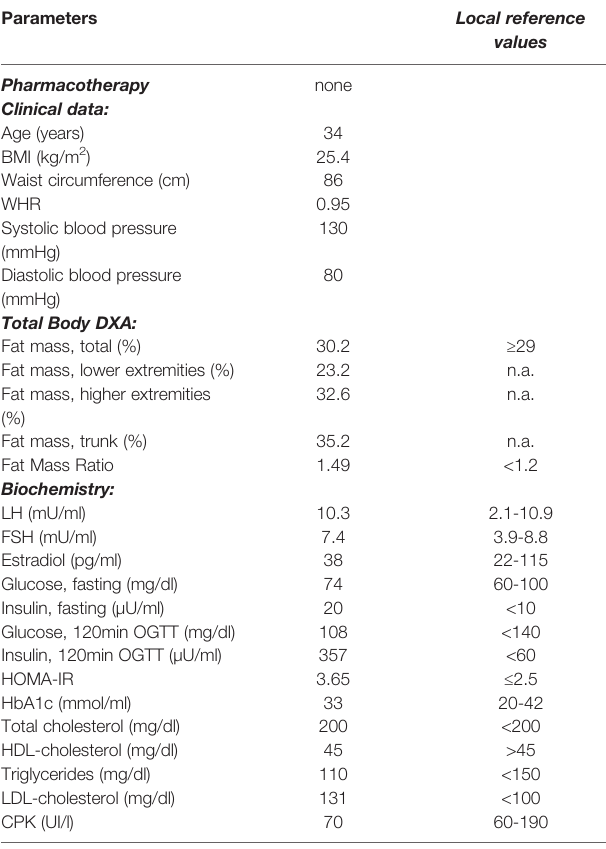
TABLE 1 | Clinical, hormonal and biochemical pro fi le of the patient at baseline. Parameters